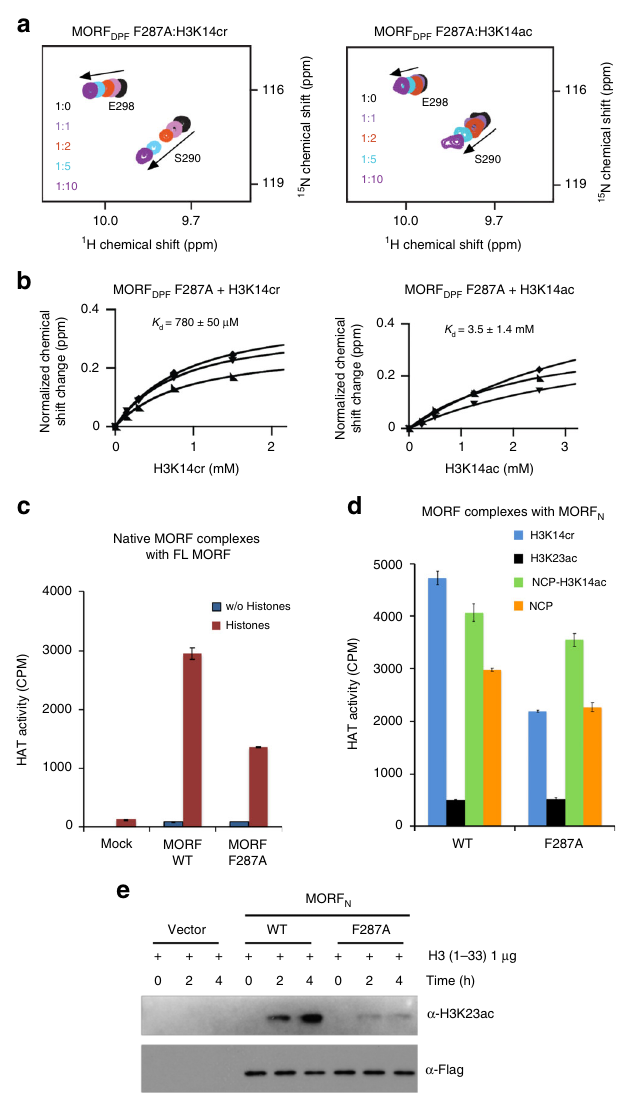
Fig. 4 H3K23 acetylation depends on functional MORF DPF . a Superimposed 1 H, 15 N HSQC spectra of MORF DPF F287A mutant collected as indicated peptides were added stepwise. Spectra are color coded according to the protein:peptide molar ratio (inset). b Representative binding curves used to determine K d s for the interactions of MORF DPF F287A with indicated peptides by NMR. Error was calculated as SD. c HAT activity of native MORF wild-type and F287A mutant complexes from K562 cells on native free core histones. Liquid HAT assays, in which reactions were spotted on P81 fi lters and counted by scintillation as counts per minute (CPM). d HAT activities of wild-type and mutated MORF N complexes puri fi ed from 293T cells using indicated H3 peptides (residues 1 – 29) or recombinant unmodi fi ed nucleosomes (NCP) or nucleosomes containing H3K14ac (H3K14ac-NCP) as substrates. Error bars in c and d indicate the range from duplicate samples, n = 2 independent experiments. e Western blot analysis of HAT assays with puri fi ed overexpressed wild-type and mutant MORF